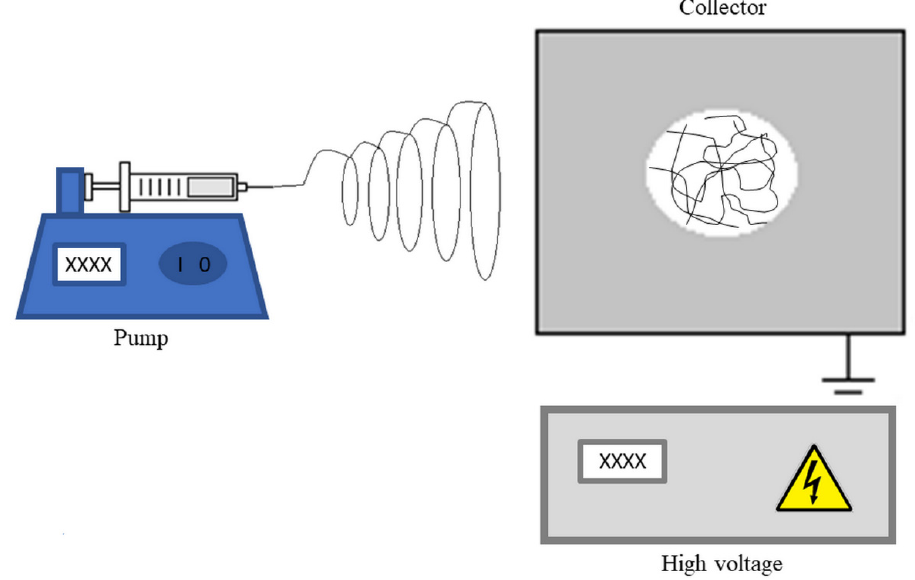
Figure 1. Electrospinning scheme. The formed fibers present morphologies and diameters depending on the solution, process, and environmental parameters used in electrospinning. The principal solution parameters are viscosity (related to polymer concentration and molar mass), conductivity, surface tension, dipole moment, and dielectric constant of the solvent. The process parameters are flow rate, applied electric field, and the distance between needle and collector (working distance). Ambient conditions that influence the process are relative humidity, temperature, and air velocity in the electrospinning chamber [12,16,17]. Based on these factors, it is essential to control the parameters during the process to analyze how each one will influence the properties of the formed